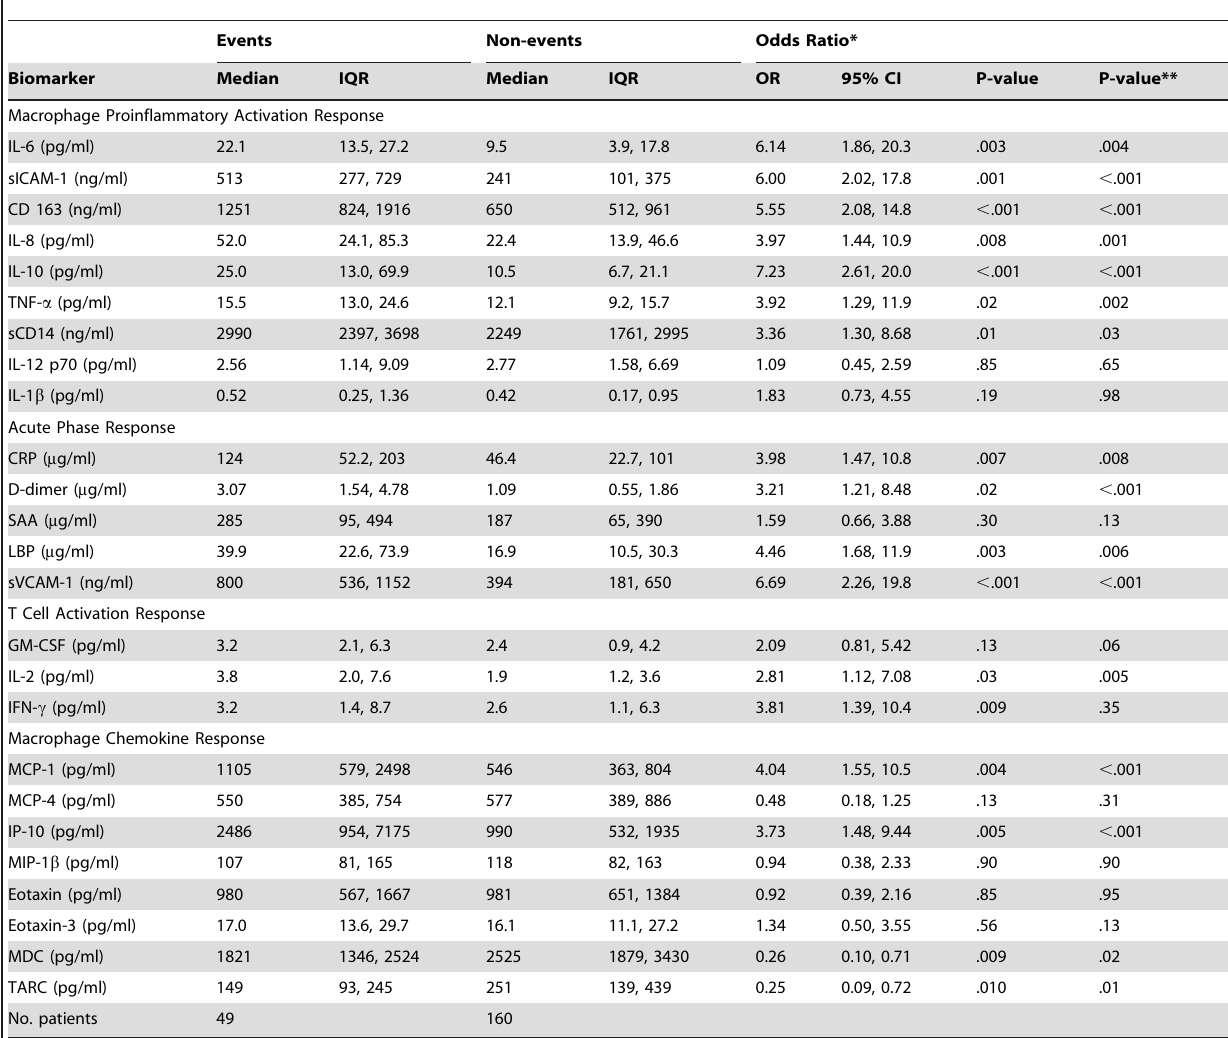
Table 5. FLU 003 Patients: Odds Ratios of Progression for the Highest Versus Lowest Tertile of Each